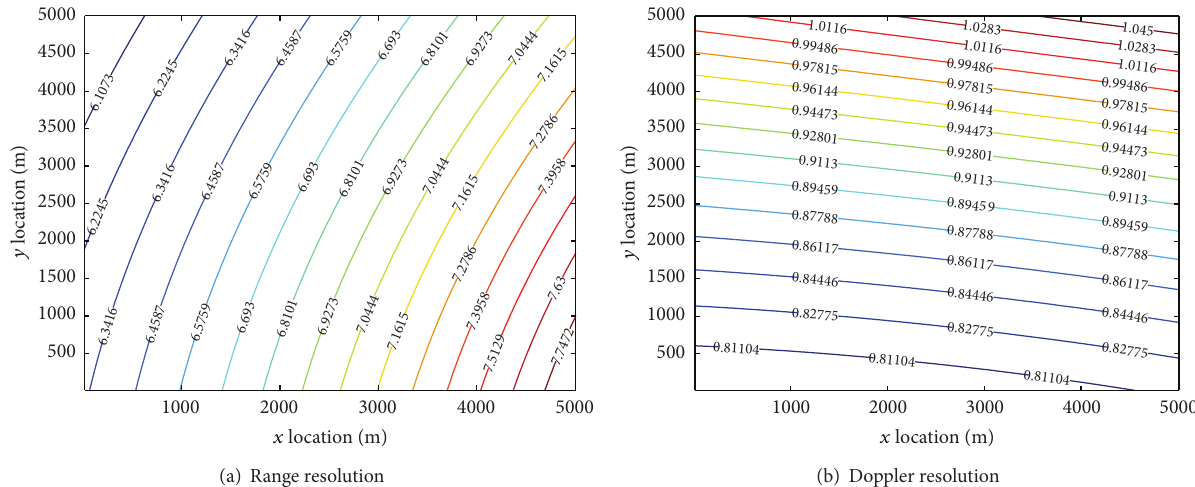
Figure 4: MBFL-SAR range resolution and Doppler resolution when 𝑡 𝑚 = 0 .